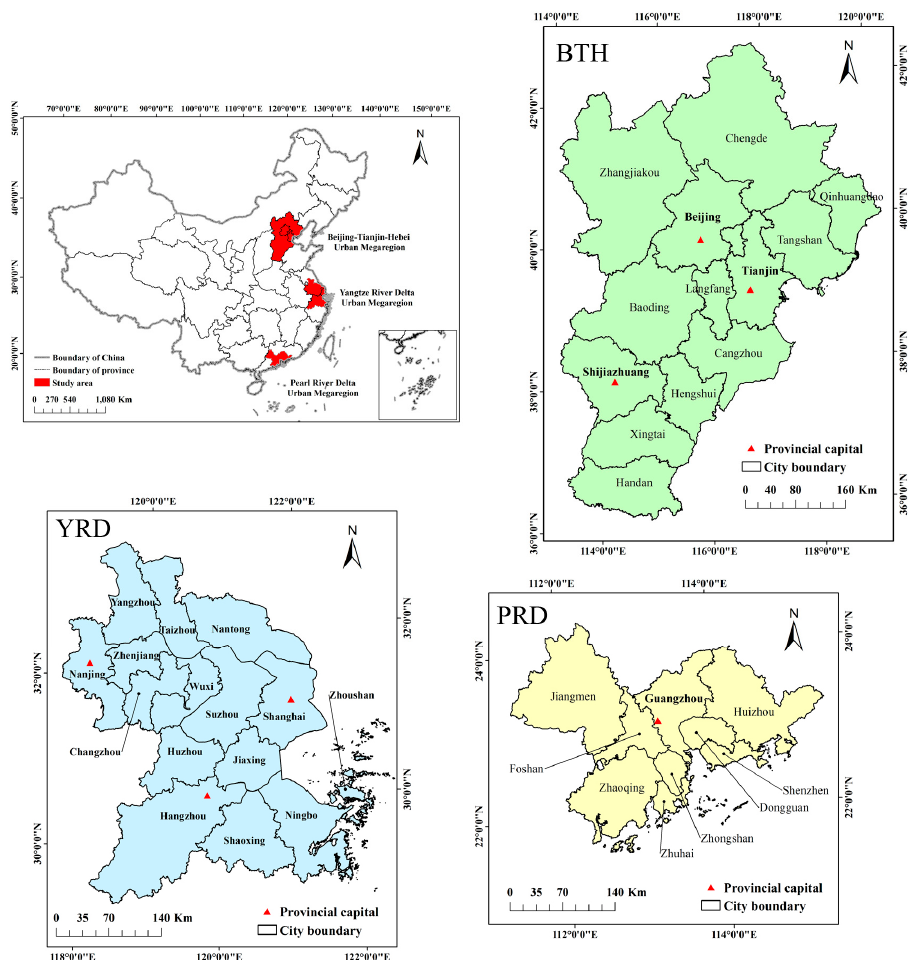
Figure 1. The spatial distribution of the three urban megaregions. The Beijing-Tianjin-Hebei (BTH) urban megaregion is located in northern China, the Yangtze River Delta (YRD) urban megaregion is in the central part, and the Pearl River Delta (PRD) urban megaregion is in southern China.